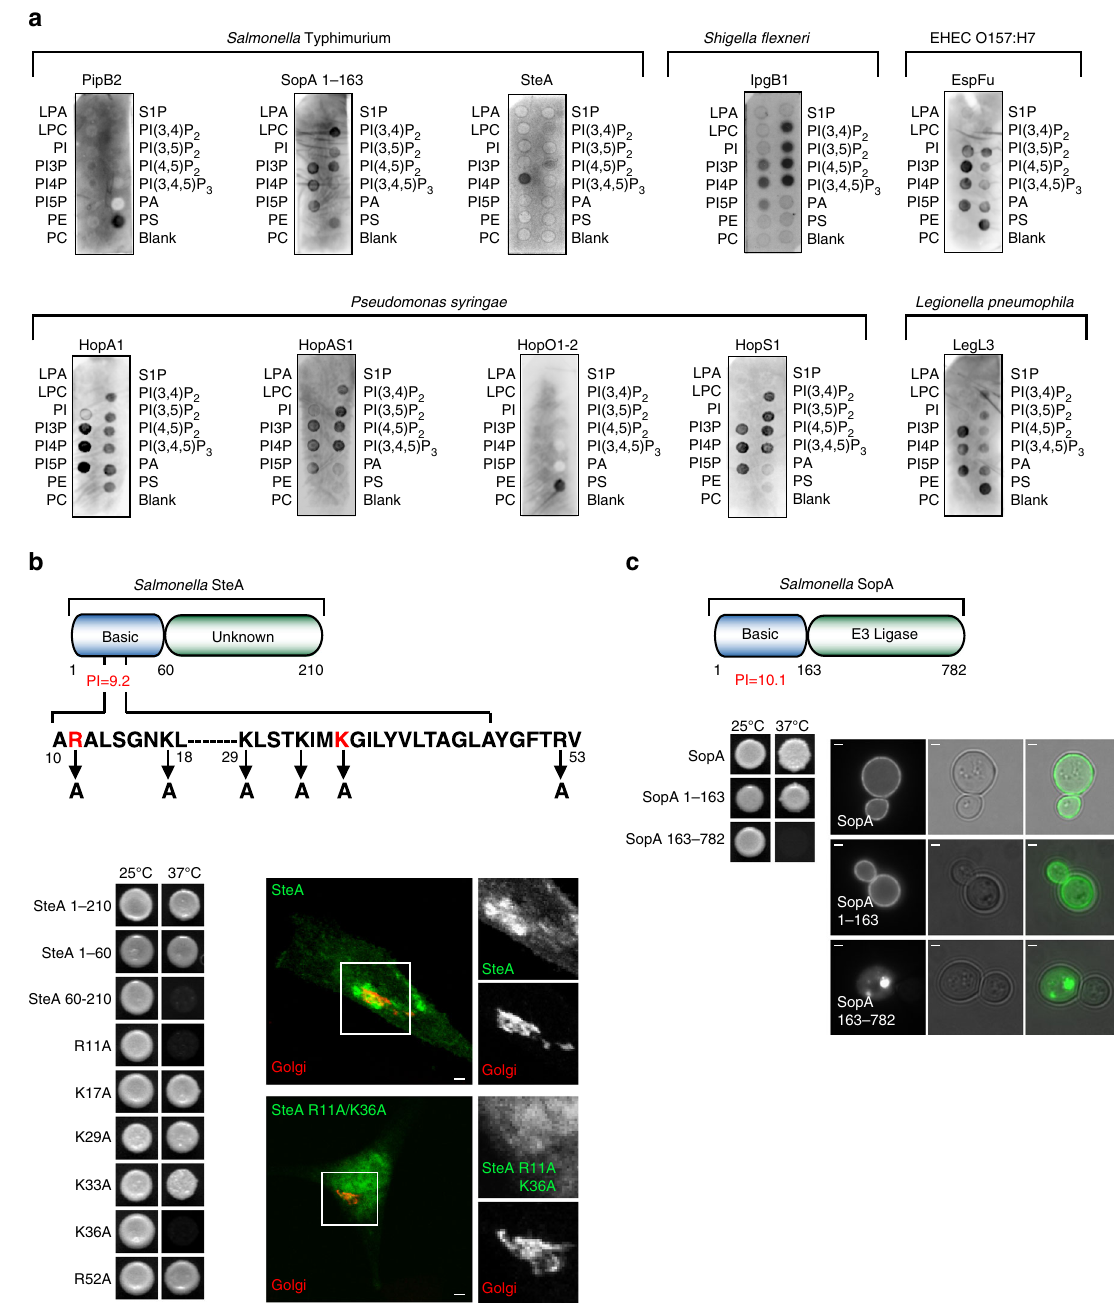
Fig. 6 Direct phospholipid interactions of bacterial effector proteins. a PIP strips of the ten effectors that changed localization in the PI kinase screen, but were not predicted to have TM domains. b SteA St truncations and mutants as listed were fused to the C terminus of Ras* and assayed for growth at the non-permissible temperature. Fluorescent microscopy of wild-type SteA St or SteA R11AK36A co-expressed with Golgi apparatus marker in HeLa cells (SteA: green , GM130: red ). Scale bar is 5 μ m and inset is ×4 magni fi ed to the right. c Ras-rescue screen using the full-length, N terminus (1-163), and C terminus (163-end) of SopA St . Fluorescent micrographs of yeast expressing GFP fusions with full-length, the N terminus, or the C terminus of SopA St . Scale bar is 1 μ m